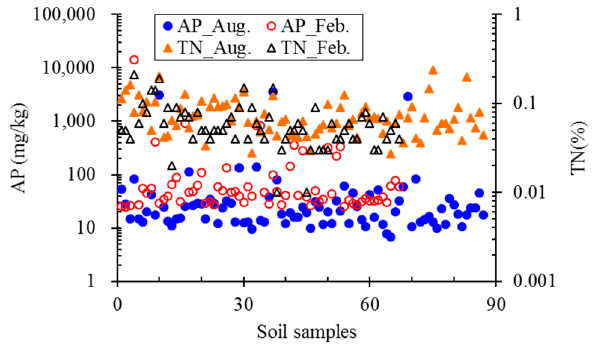
Figure 9. Comparison of available phosphorus (AP) and total nitrogen (TN) contents in soil monitored during rainy (solid symbols) and dry (hollow symbols) seasons in the Mun River Basin.